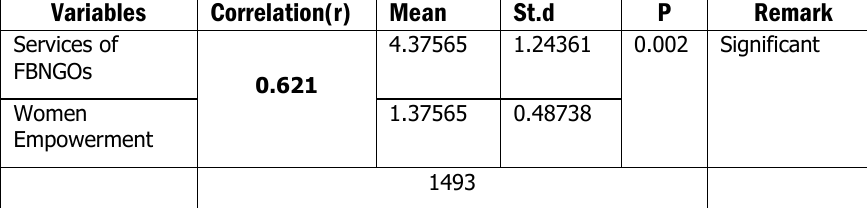
Table 6: Correlation Analysis of the NGOs Services and Women Empowerment